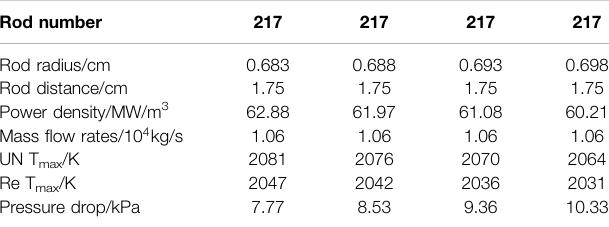
TABLE 3 | Summary of simulated rod bundle parameters in mass fl ow rate fi xed analysis. Rod number